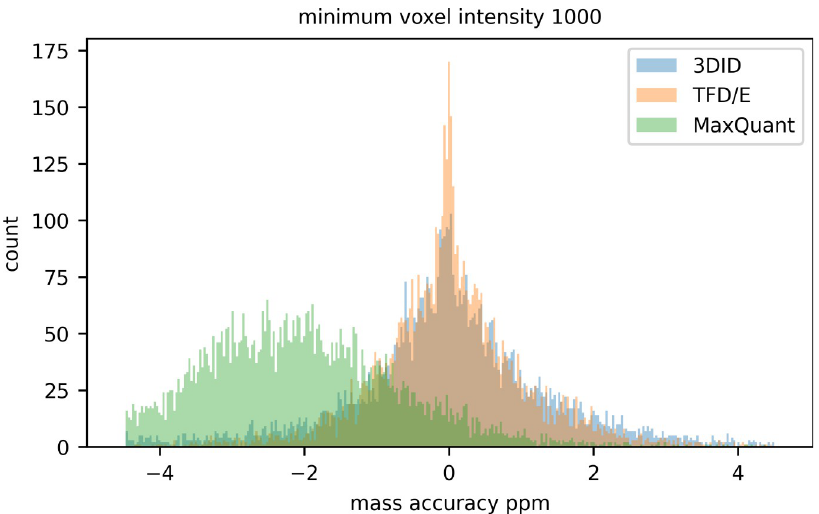
Fig 12. Mass accuracy ppm of identified features detected by 3DID, TFD/E, and MaxQuant.